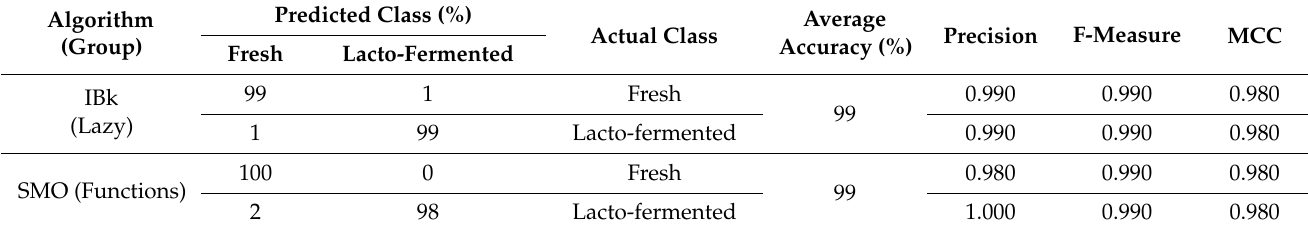
Table 6. The discrimination performance metrics for models developed on the basis of selected